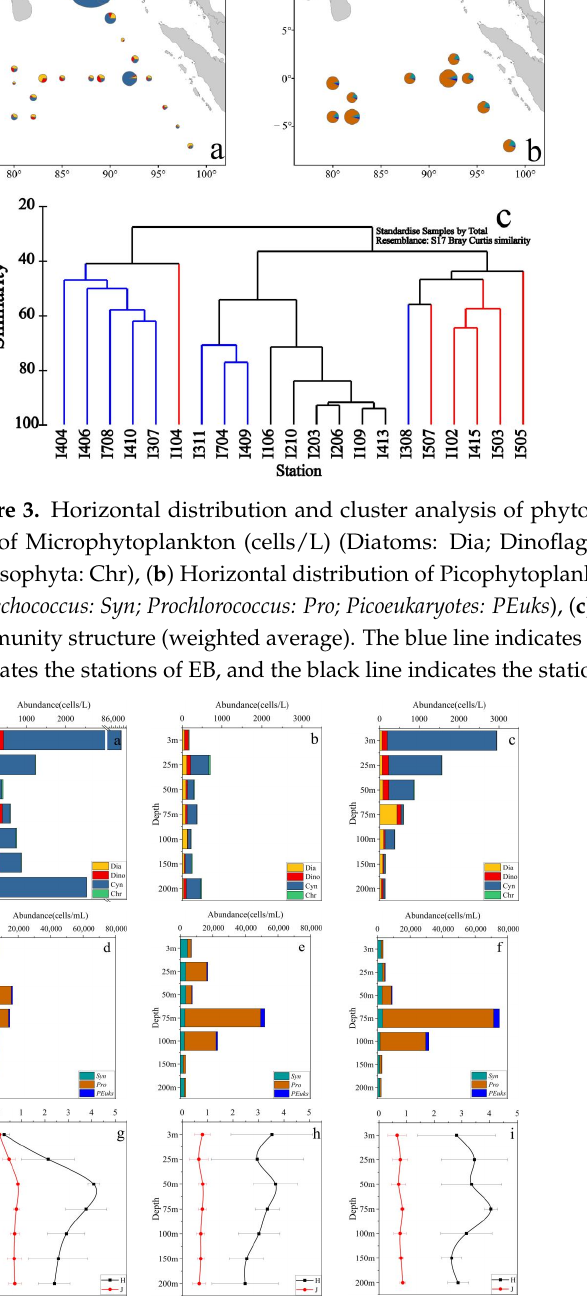
Figure 4. Vertical distribution of Microphytoplankton (Diatoms: Dia; Dinoflagellate: Dino; Cyano ‐ bacteria: Cyn; Chrysophyta: Chr), Picophytoplankton ( Synechococcus: Syn; Prochlorococcus: Pro; Picoeukaryotes: PEuks ), Shannon ‐ Wiener diversity index ( H’ ), and Pielou index ( J ) in different sub ‐ regions of the eastern Indian Ocean in spring 2017. ( a ) Microphytoplankton in BOB, ( b ) Microphy ‐ toplankton in EB, ( c ) Microphytoplankton in EQ, ( d ) Picophytoplankton in BOB, ( e ) Picophyto ‐ plankton in EB, ( f ) Picophytoplankton in EQ, ( g ) H’ and J in BOB, ( h ) H’ and J in EB, ( i ) H’ and J in EQ.